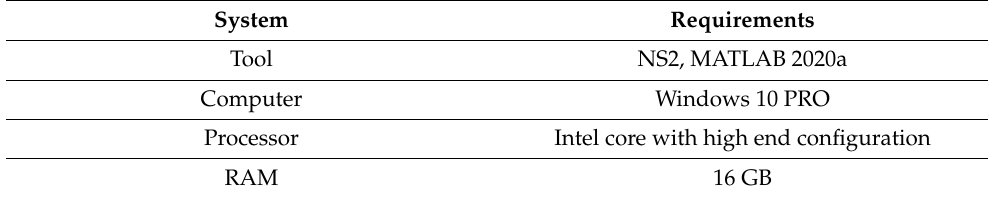
Table 2. Configuration of